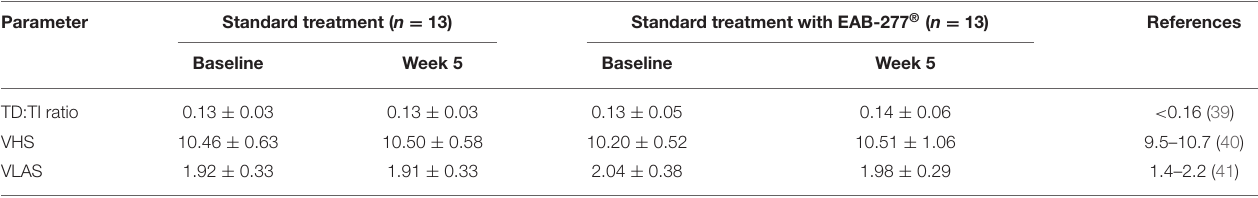
TABLE 4 | Radiography parameters of standard treatment and EAB-277 ® groups at baseline and at week 5. Parameter